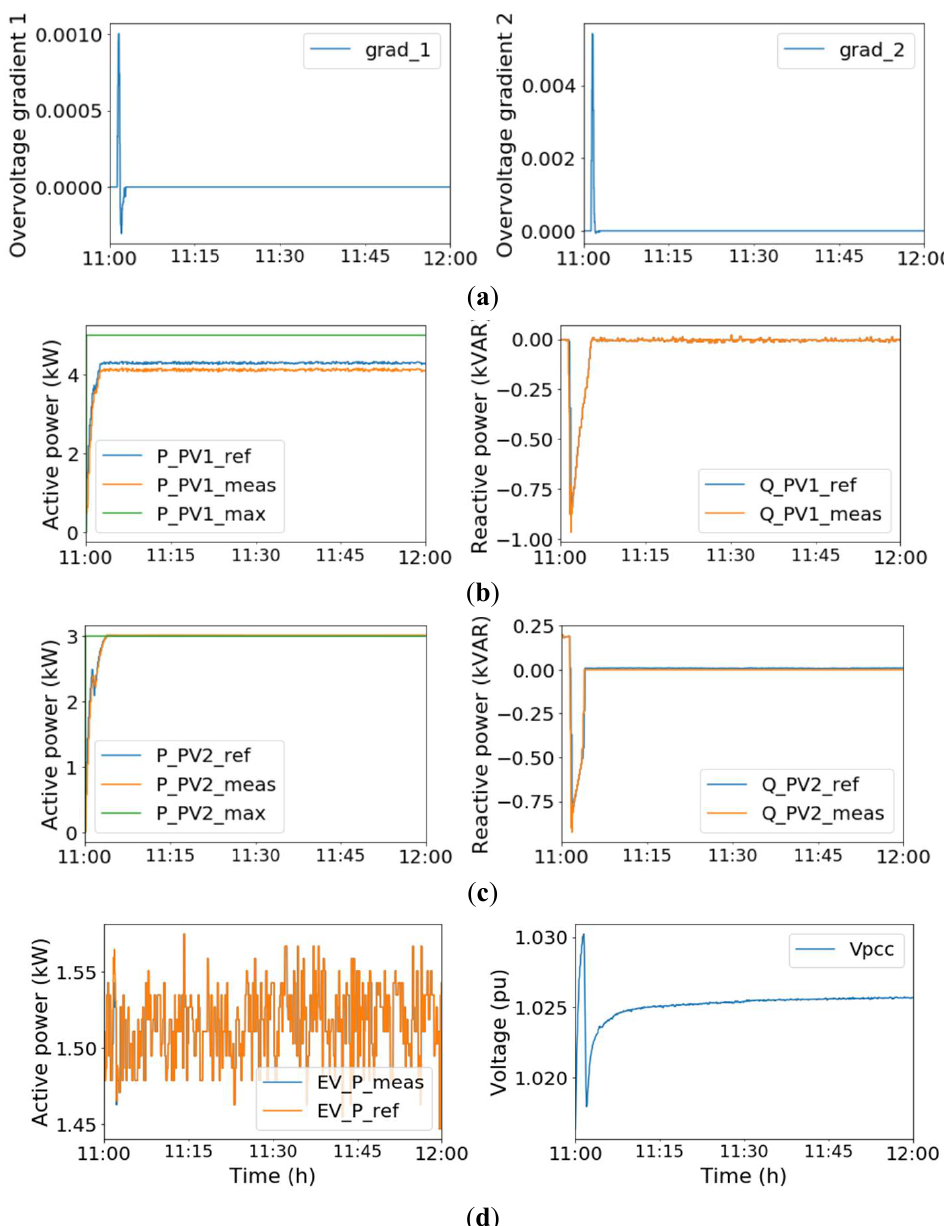
Figure 18. Results of hardware Heila DER local controller for Rack 2: ( a ) the dual variables received from the Heila coordinator; ( b ) the optimal power set points and measurements of PV inverter 1; ( c ) the optimal power set points and measurements of PV inverter 2 and ( d ) the optimal power set points and measurements of the EV ( left ) and the PCC voltage of Rack 2 ( right ).